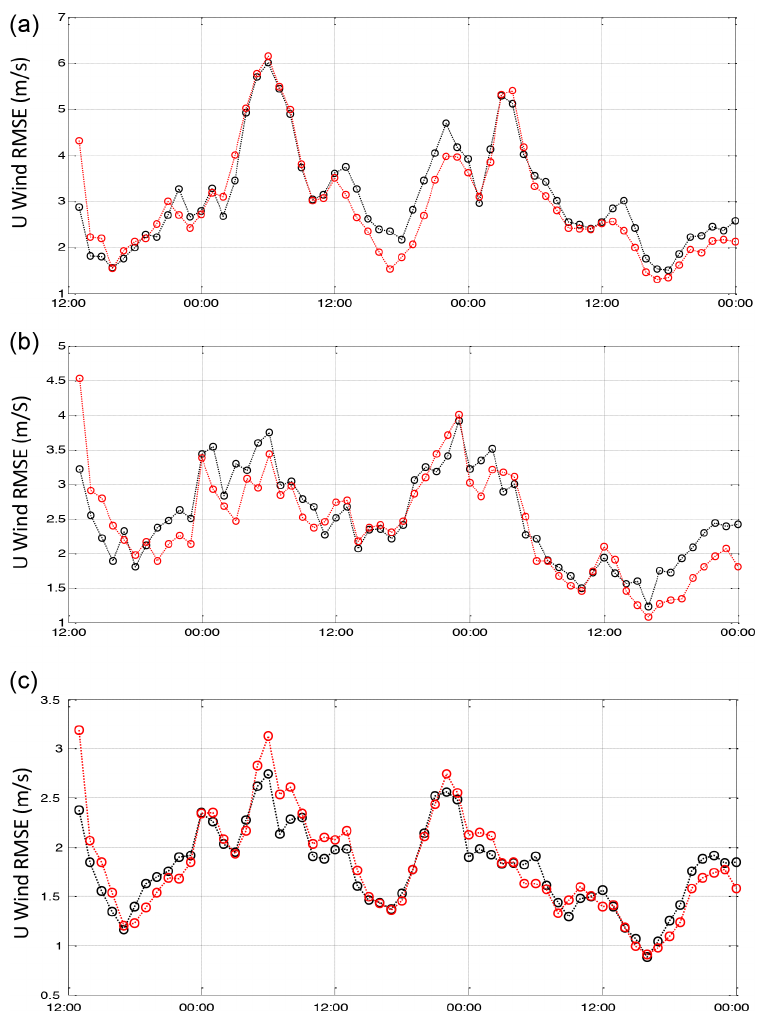
Figure 4. RMSE for the U winds in the urban assimilation domain. (a) Free (black) vs. CHEM (red). (b) ( T , RH) (black), ( T , RH, CHEM) (red). (c) MET (black), (MET, CHEM) (red). Note the change in